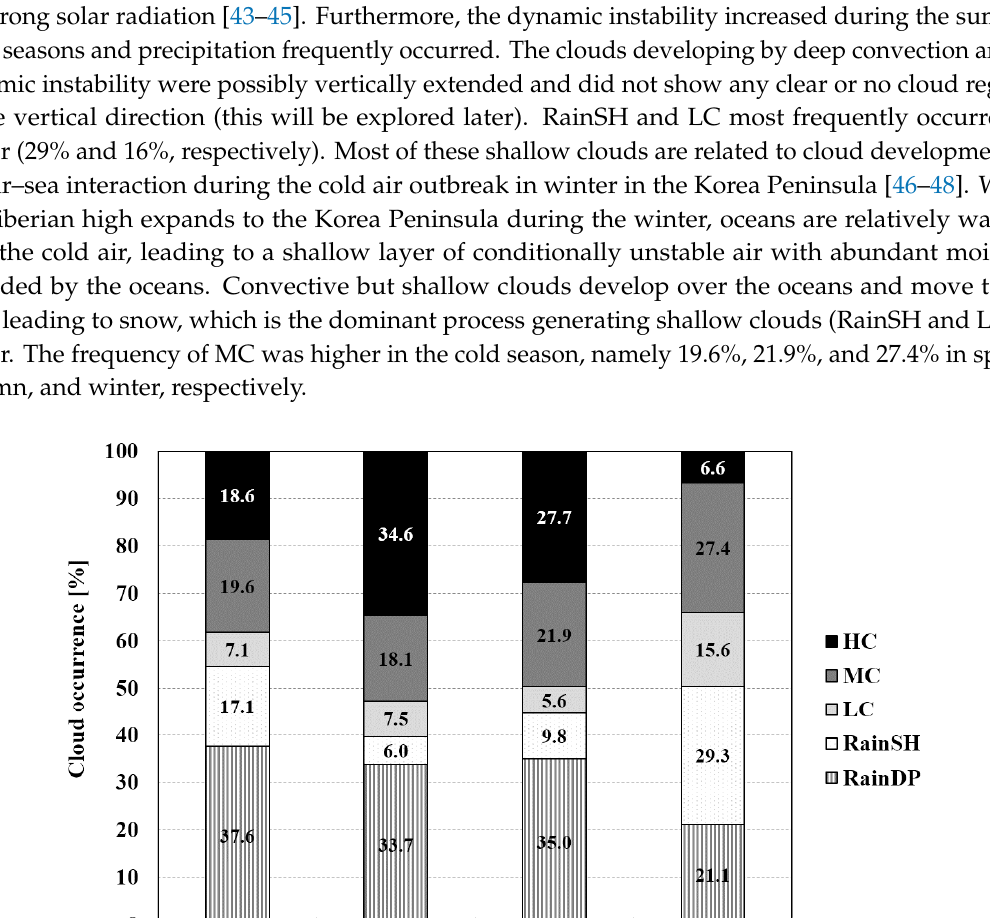
seasonal occurrence of clouds (6.5% in spring, 15.6% in summer, 8.6% in autumn, and 5.2% in winter), the